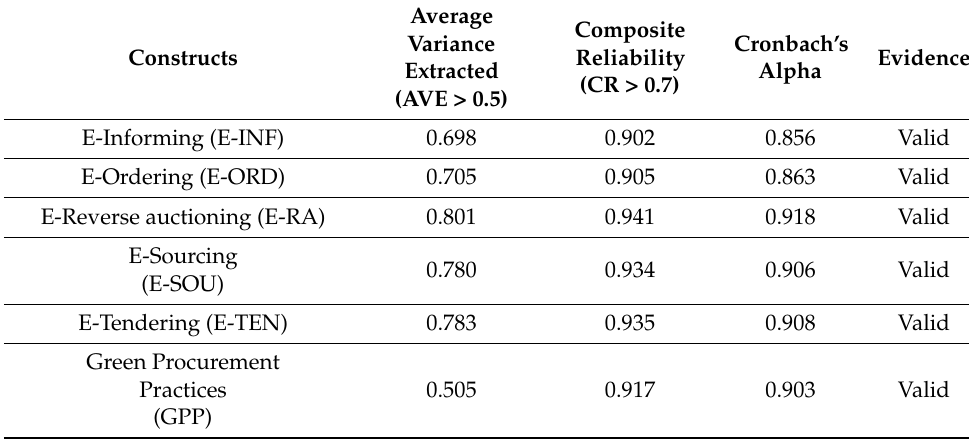
Figure 4. Describing research model path using SmartPLS. Table 4. Construct reliability and